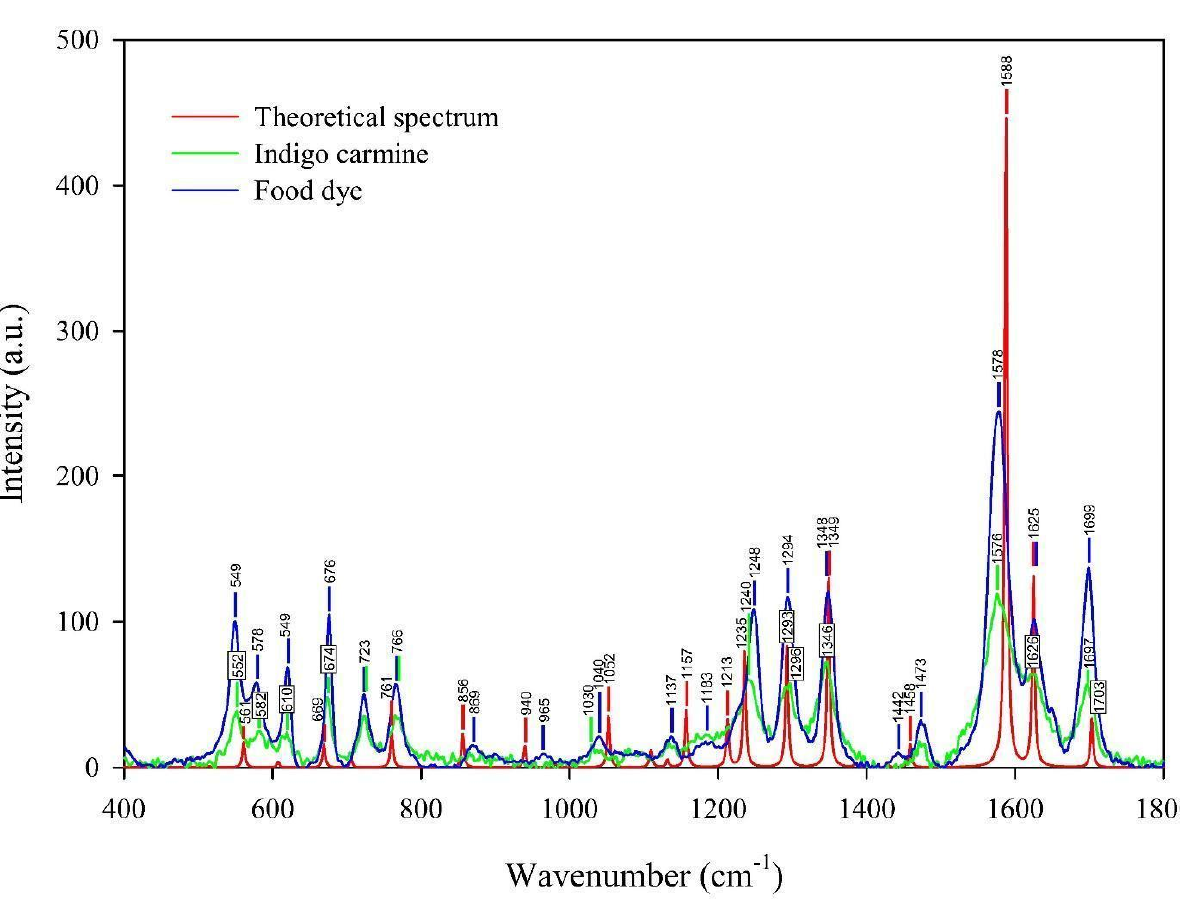
Figure 2. The experimental Raman spectra of the indigo carmine standard and the food dye indigo carmine, together with the theoretical calculated Raman spectrum of standard indigo carmine.